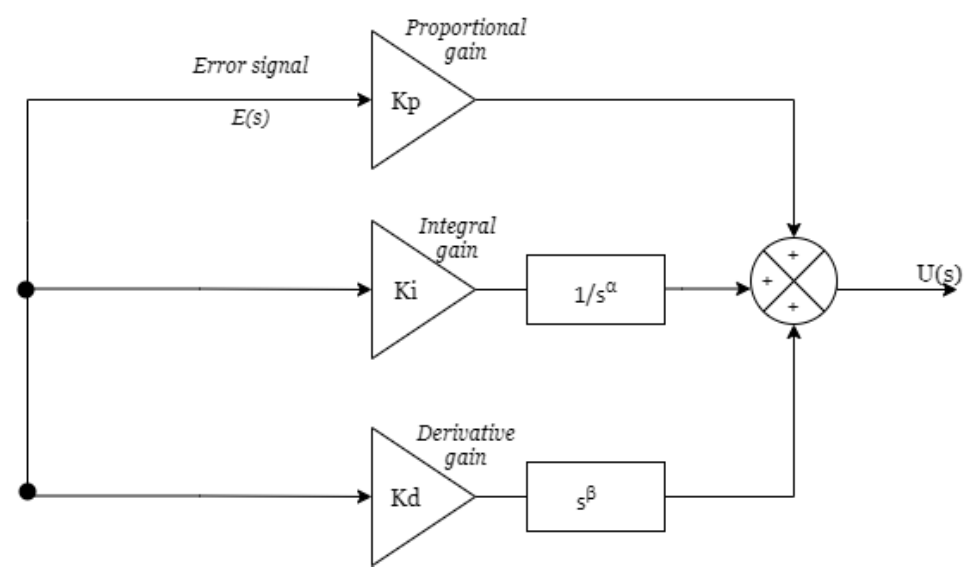
Figure 2. Fractional order PID